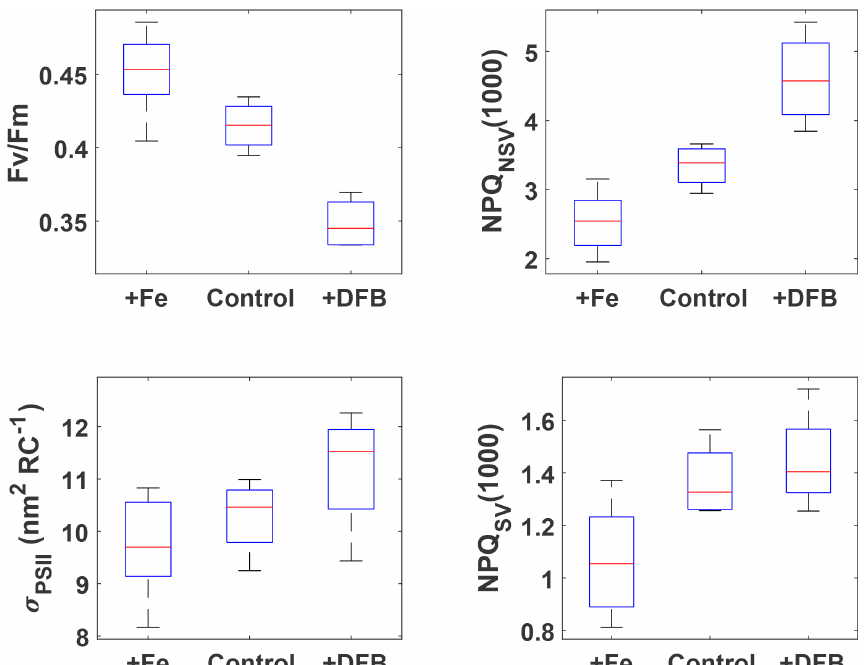
Figure 2. FRRf results after ∼ 53h for the three pooled incubation experiments. The respective treatments are indicated on the x axes (2 and 0.2nM Fe additions were pooled into + Fe), and measured parameters are on the y axes. NPQ capacity was estimated at 1000µmolquantam − 2 s − 1 after 24min exposure to increasing actinic light intensities (see Fig. S2 for details of the fluorescence light curves). Box plots show the sample medians in red, with the blue boxes indicating the 25th and 75th percentiles; whiskers extend to the most extreme data points. All + Fe treatments were significantly different from the respective DFB treatments (Wilcoxon rank-sum test, p < 0 . 05), and all + Fe treatments, except for σ PSII , were also significantly different from the respective control